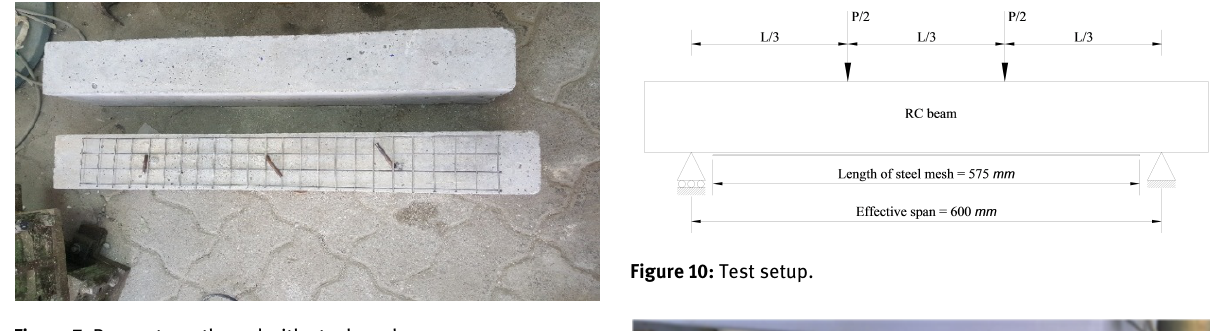
Figure 7: Beam strengthened with steel mesh.